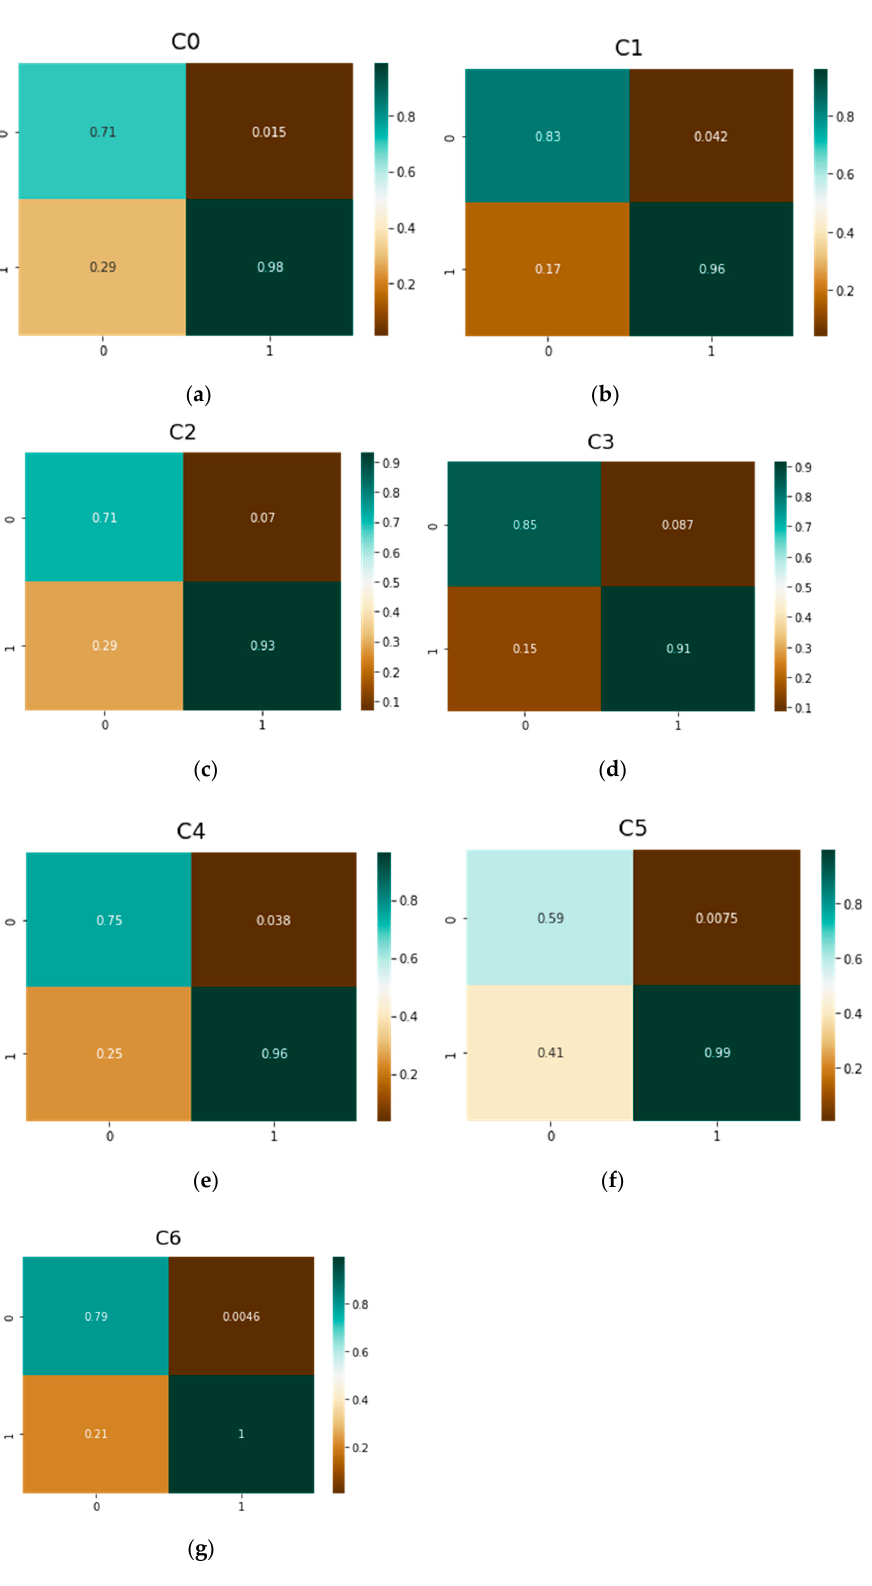
Figure 10. The multi-classification model based on vit-base-patch16-224. The confusion matrices for